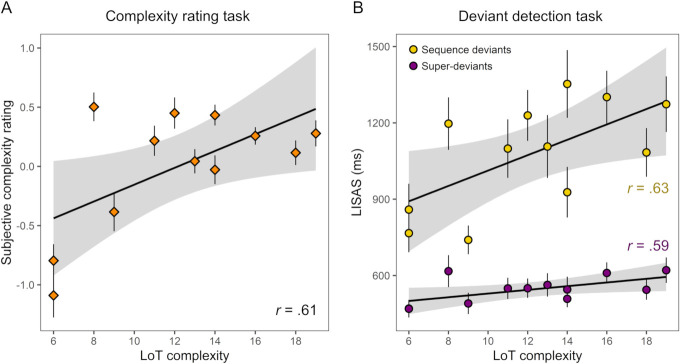
Linear relationship between LoT complexity and scores obtained in the two tasks of experiment 2 with 12-item auditory sequences (with 95% confidence intervals bands in gray).Same format as Fig 3.